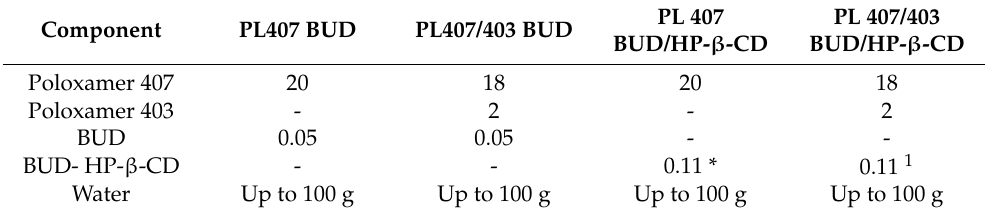
Table 1. Hydrogel percentage composition ( w / w ).